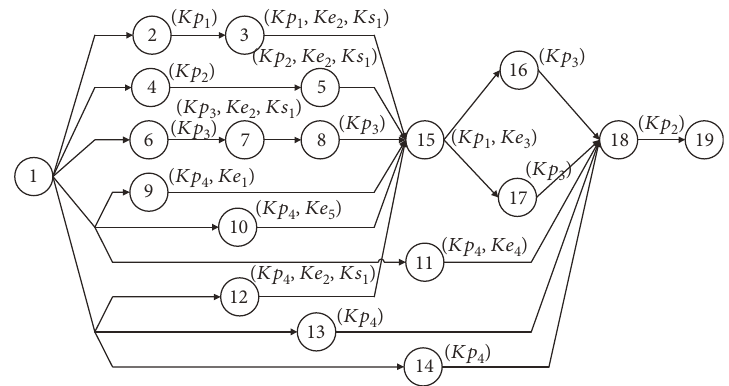
Figure 7: The general OONF network of a single